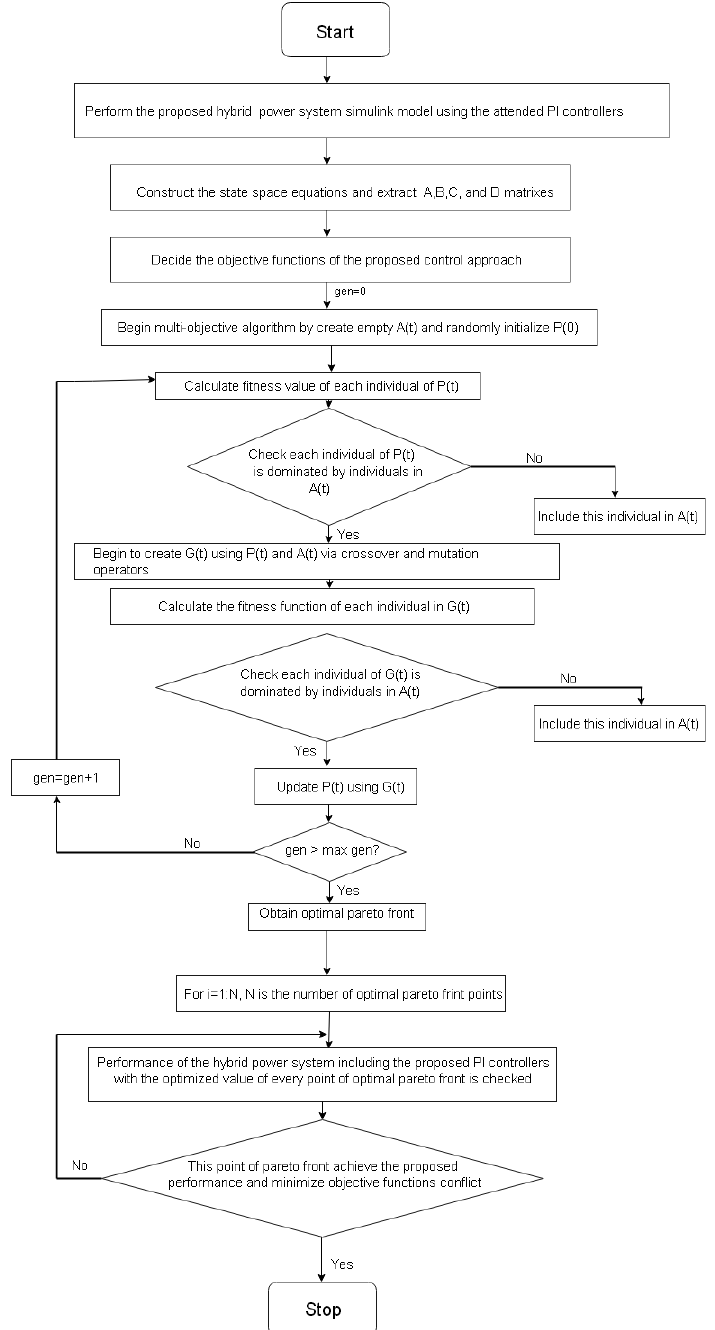
Figure 6. Flowchart of the epsilon multi-objective genetic algorithm ( ε -MOGA)-based PI controllers’ design